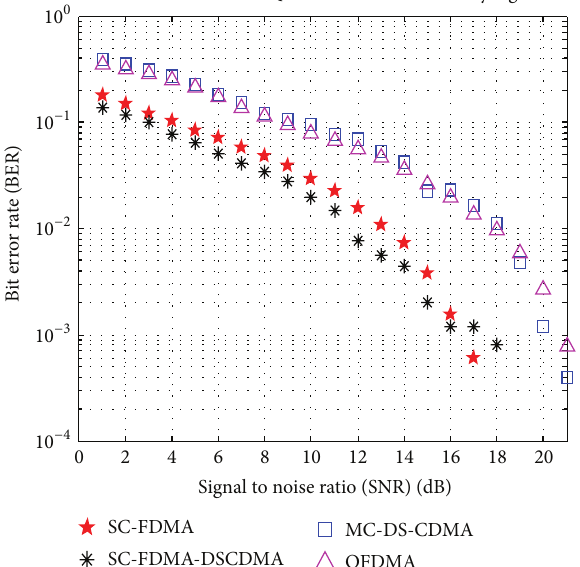
Figure 3: BER performance of the proposed SC-FDMA-DSCDMA technique compared with other multicarrier techniques (over Rayleigh channel). BER performance of the proposed technique is again best and very close to that of SC-FDMA. No degradation due to modified